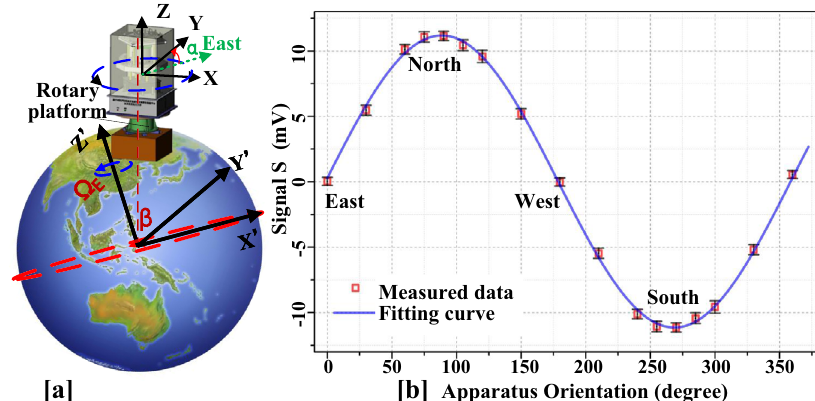
of ^ y withrespecttotheeastdirectioninthehorizontalplane. b Themeasured dots at different direction are fi tted by a sinusoidal function. The error bars represent statistical errors (standard